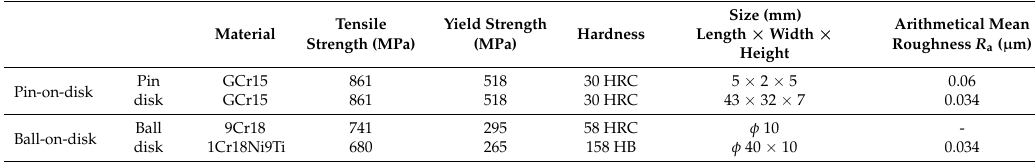
Table 1. Parameters of the pin-on-disk and ball-on-disk configurations.